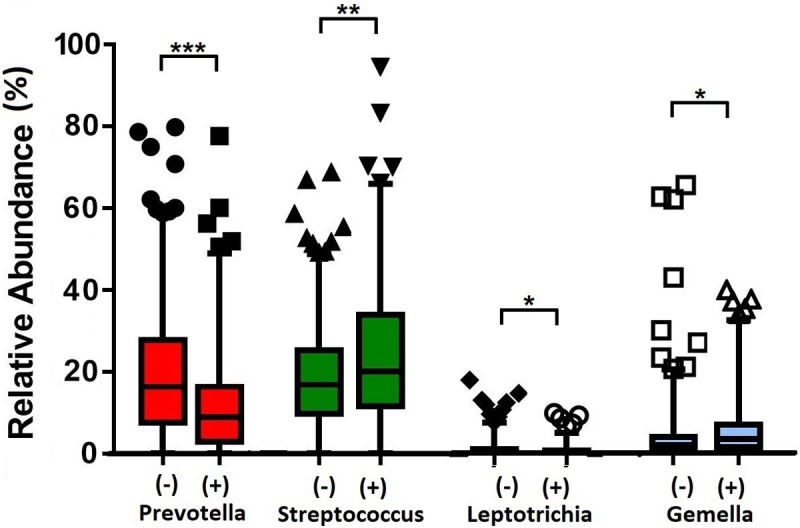
Relative abundances of significant genera between 245 case and 386 control samples.AMD-positive and control samples are denoted by (+) and (-) respectively. Statistical significance is indicated by (*Adj-p < 0.05), (**Adj-p < 0.005) or (***Adj-p < 0.0005). Mean relative abundances, standard deviations and P-values are presented in S4 Table.